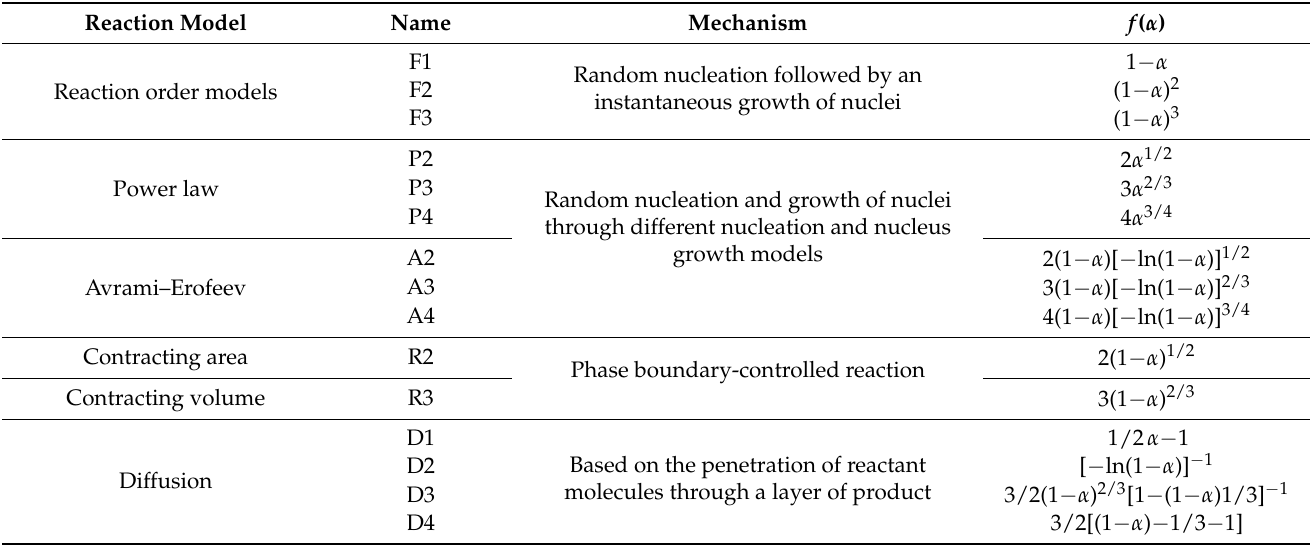
Table 1. Kinetic models ( f ( α )) for the most representative gas–solid